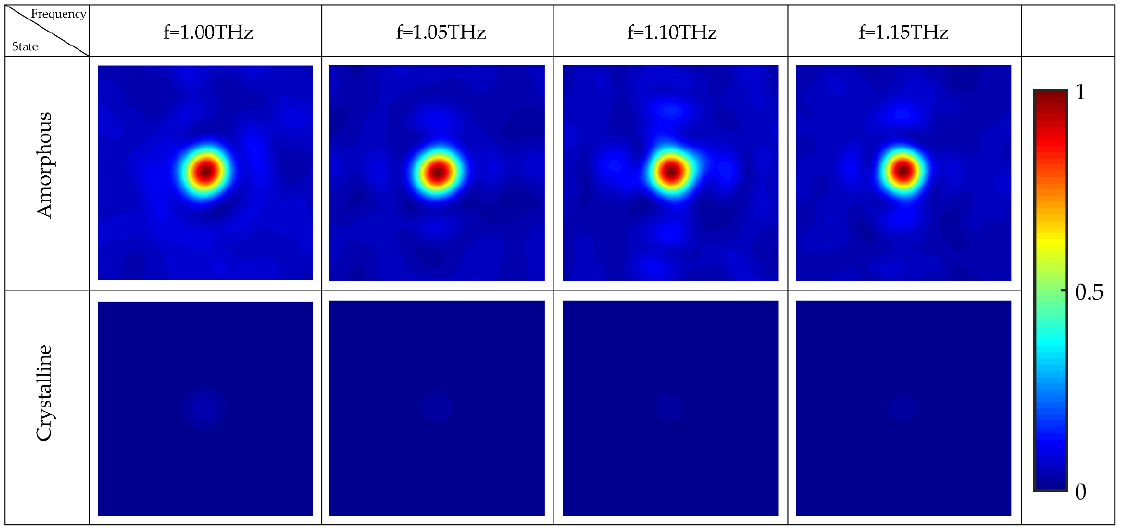
Figure 9. The focus situation of four reflective focusing metalenses at four frequencies in different GST states. GST